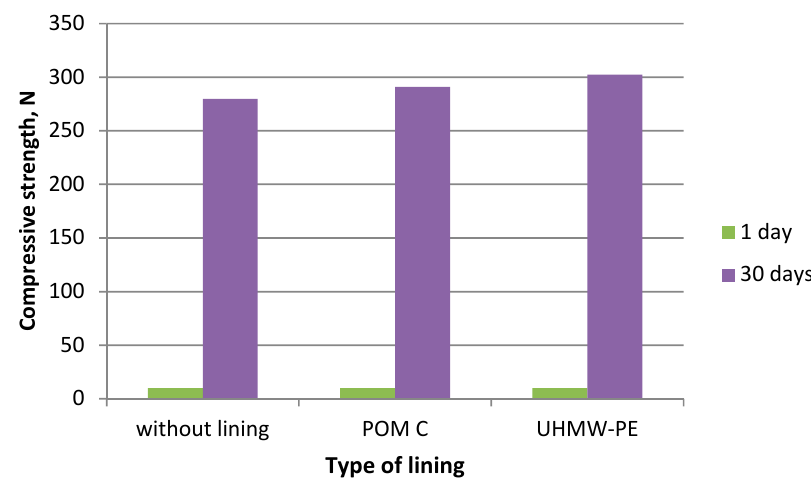
Figure 10. Drop strength of briquettes made of Mixture 3 (charcoal fines mixed with 4% of starch).